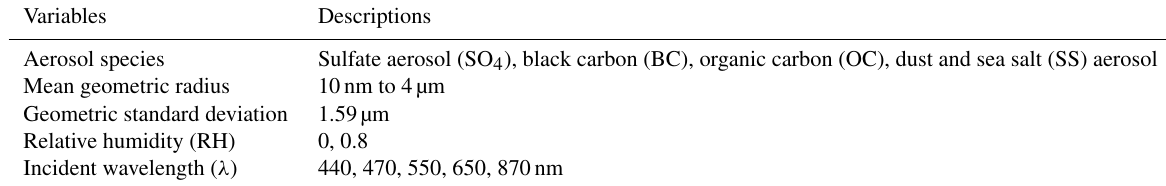
Table 2. Control variables in the aerosol extinction sensitivity